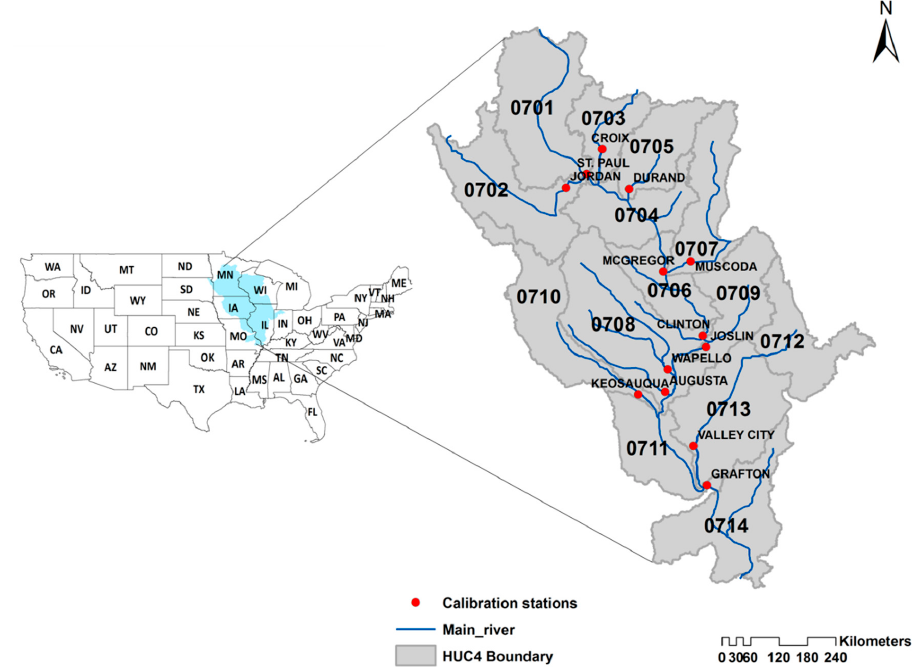
Figure 1. Location of the Upper Mississippi River Basin (UMRB) displaying four-digit Hydrological Unit Coded (HUC4) subbasins and calibrated streamflow gauge stations.